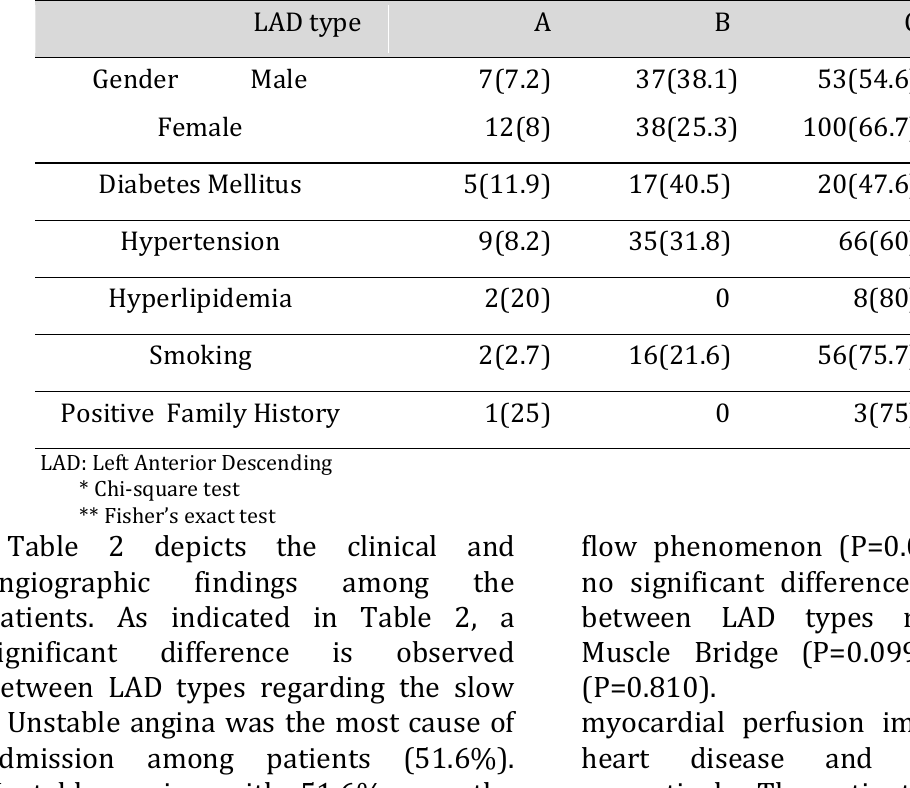
Table 1. Demographic characteristics of patients